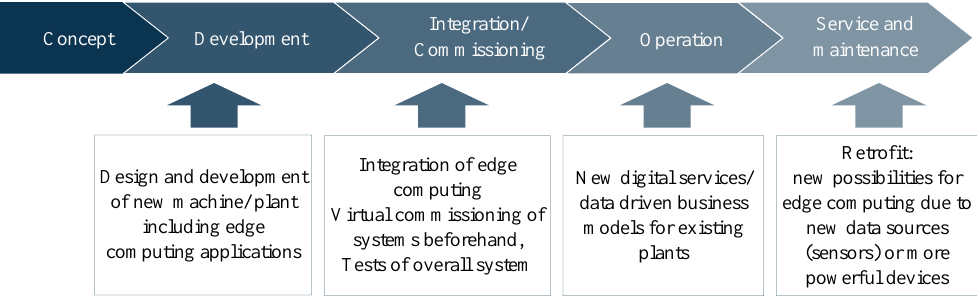
Figure 3. Application of simulation for VICO of DSPSs in different life cycle stages of a